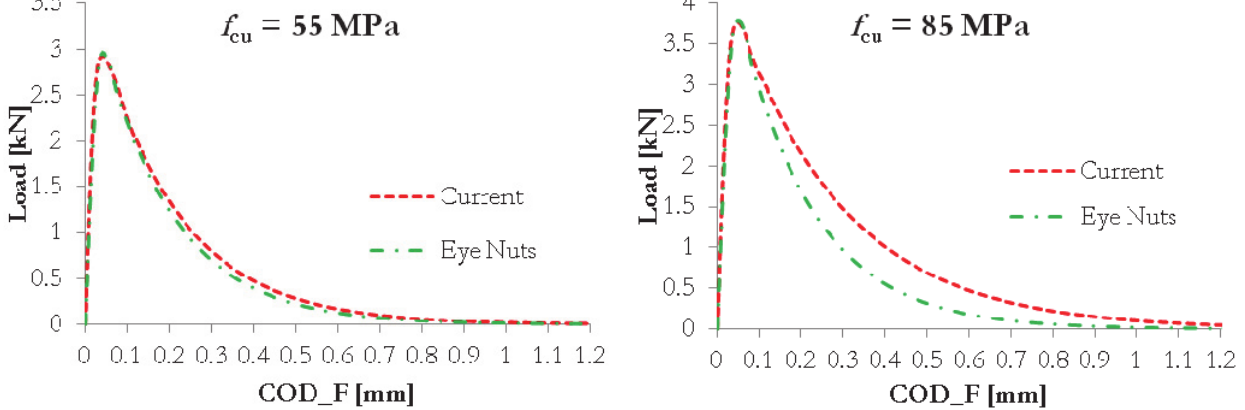
Figure 6: The final Load-COD_F diagrams for f cu 55 and 85 MPa used for the calculation of fracture energy values.